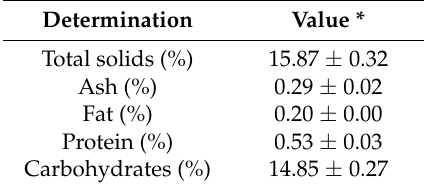
Table 1. Mean composition ( n = 2) of the probiotic functional carbonated